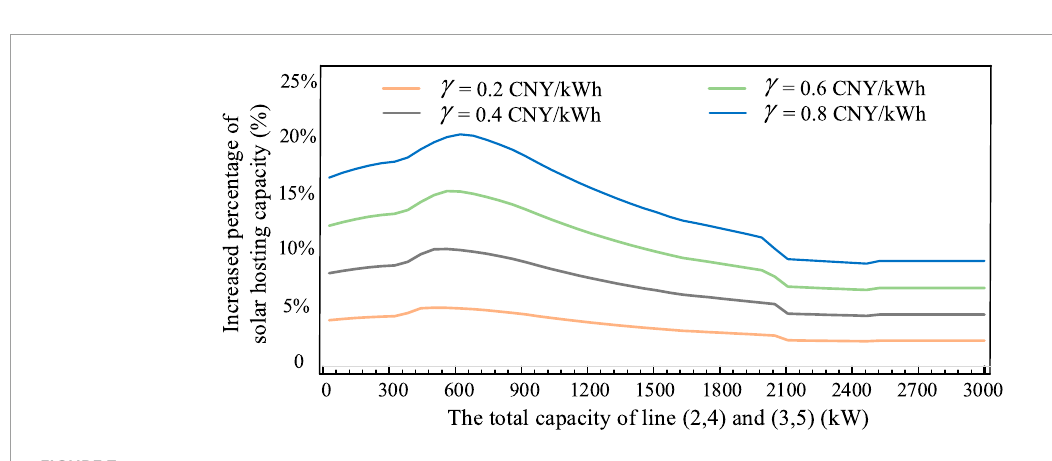
FIGURE 7 Impact of distributed photovoltaic subsidies on solar HC for different values of the total capacity of lines (2.4) and